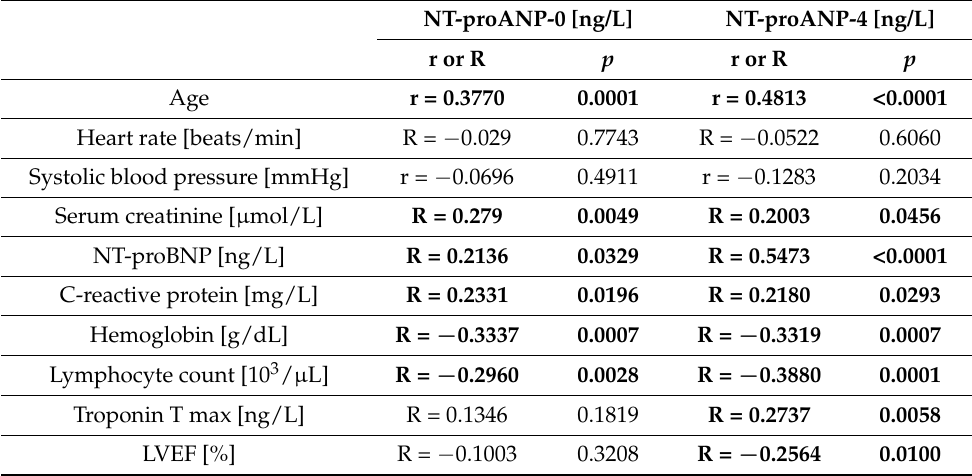
Table 4. Association between patient characteristics, laboratory tests, echocardiography findings and NT-proANP concentrations on admission (NT-proANP-0) and on the 4th day of hospitalization